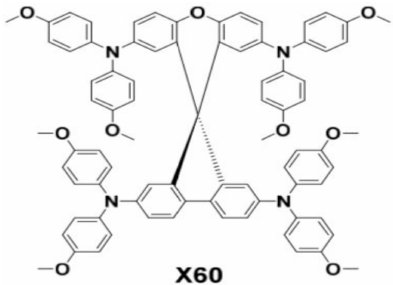
Figure 1. The structure of X60 as used by Xu et al. [61].